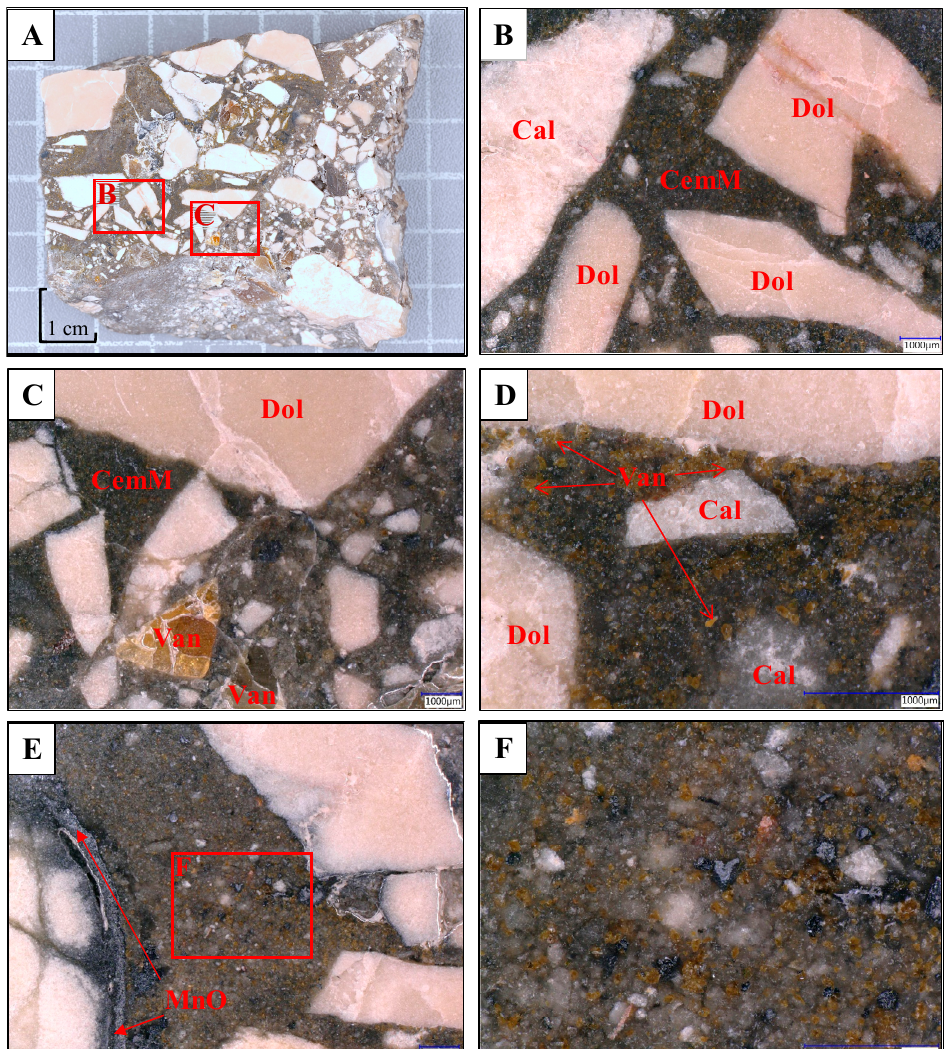
Figure 3. ( A ) Hand-specimen photograph image of sedimentary rock sample with macroscopically visible brecciated cemented dolomite and calcite; ( B – E ) Microscopic image of polished section: CemM-cemented materials; Dol-Dolomite; Cal-Calcite; Van-Vanadinite; ( F ) Microscopic image of texture of cemented material.